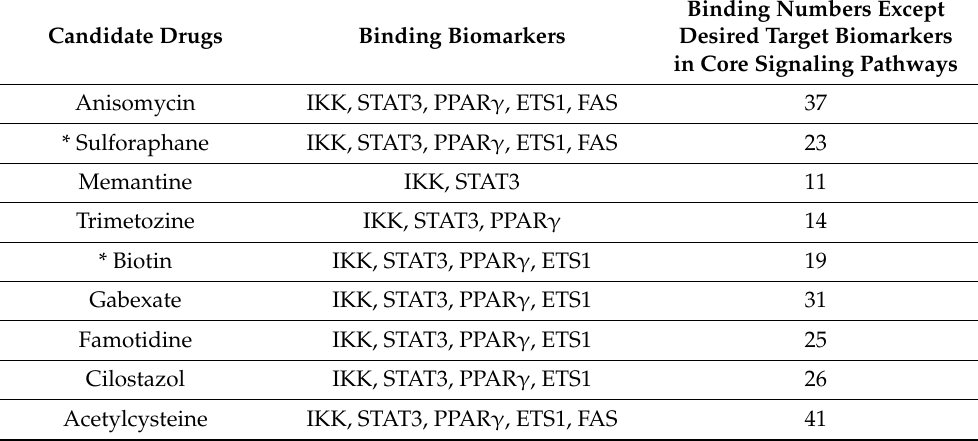
Table 5. The side effect for candidate drugs on core signaling pathways.